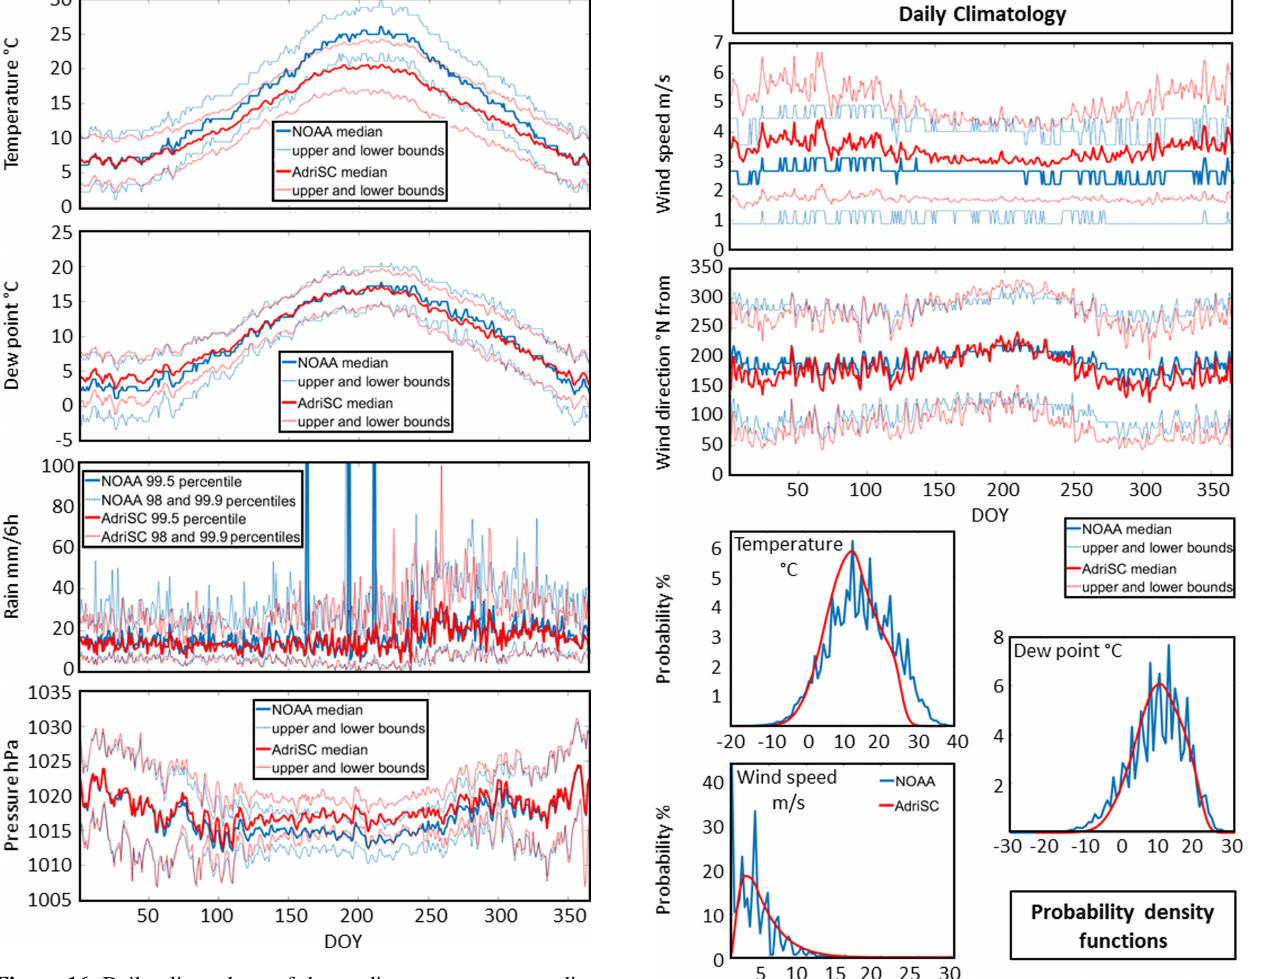
Figure 16. Daily climatology of the median temperature, median dew point, extreme rain (i.e. 99.5th percentile), median pressure and their variabilities (i.e. upper and lower bounds defined as ± MAD or 98th and 99.9th percentiles for the rain) for both the AdriSC WRF 3km model results and NOAA measurements over the entire do- main and 1987–2017 period. The abbreviation DOY stands for day of year.